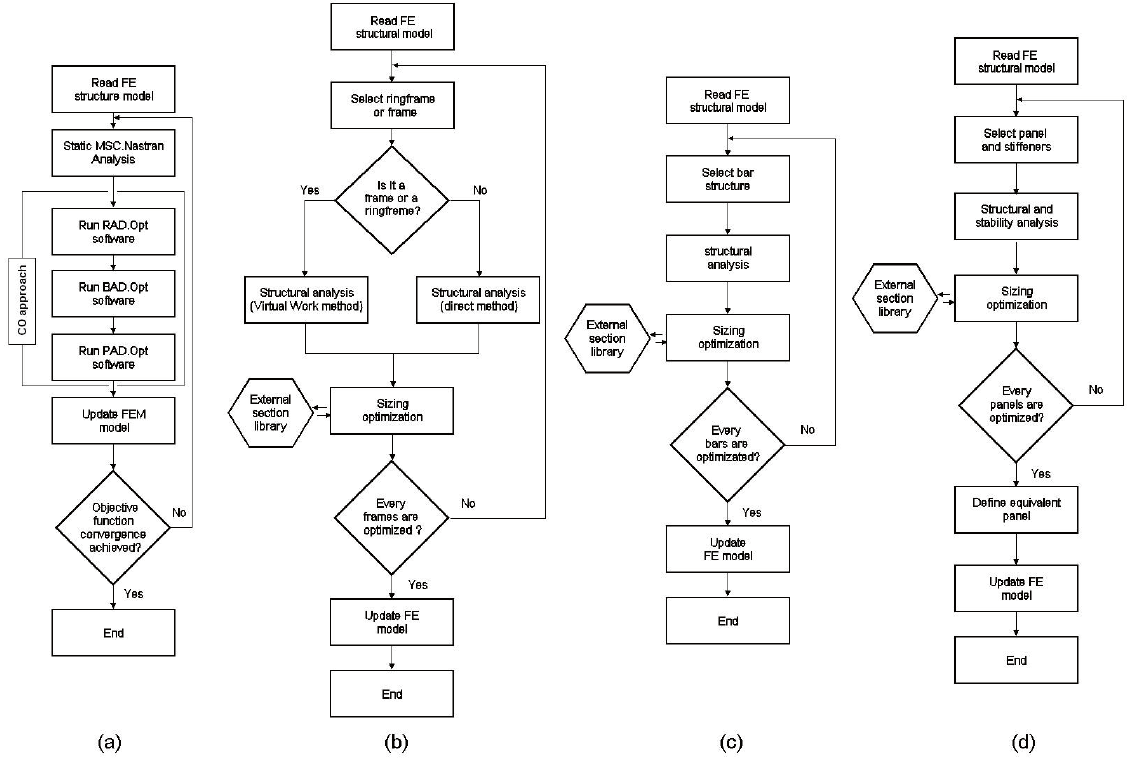
Fig. 1. The flow chart for the global procedure OPT.TOOL (a) and for the local optimization software: RAD.Opt (b), BAD.Opt (c) and PAD.Opt